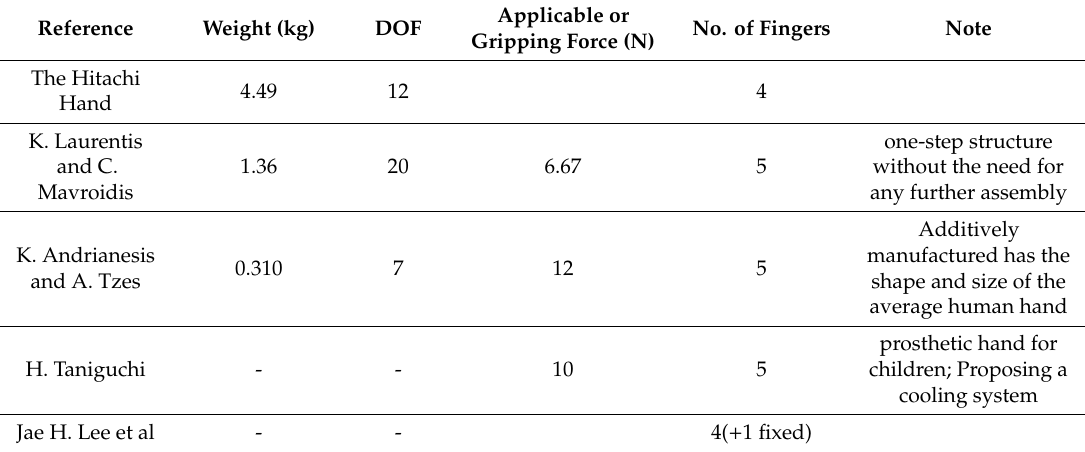
Table 3. Comparison of different prosthetic hands discussed in this paper.